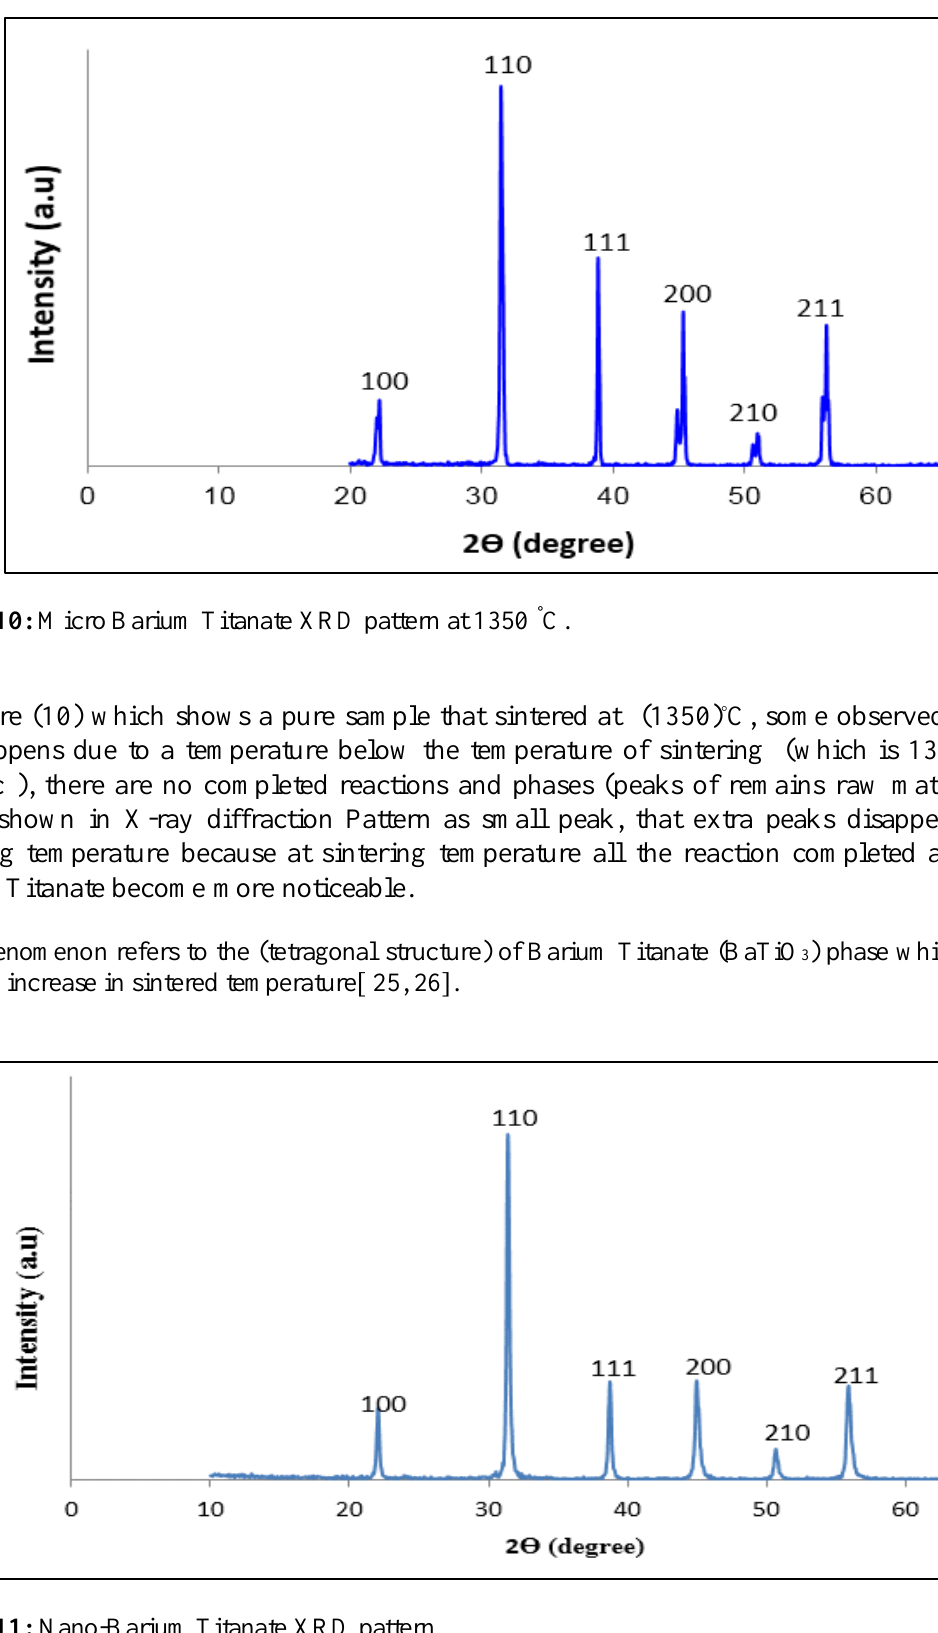
Figure 11: Nano-Barium Titanate XRD